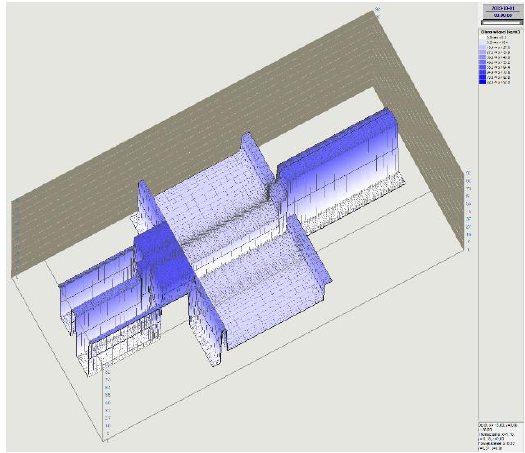
Figure 31. A 3D visualisation of changes in water content for the analysed section, assumed for the alternative with internal insulation in the initial state.